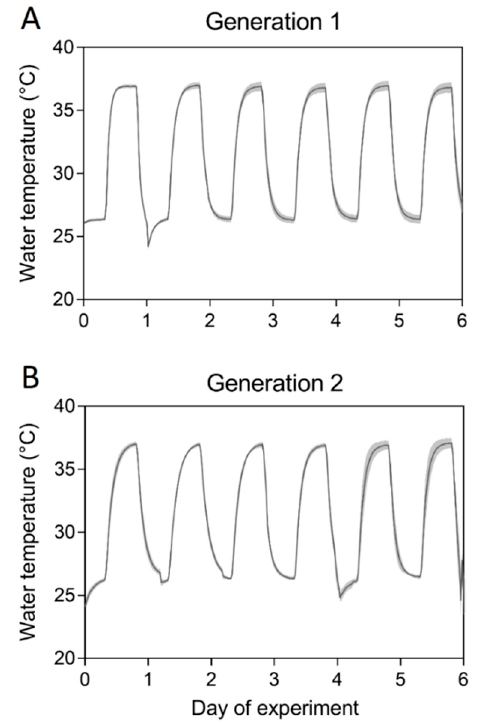
Figure A1 . Diurnal fluctuating temperatures in water containers in the first ( A ) and second ( B ) generation. Black lines indicate the mean temperature recorded by 6 iButtons, with the shaded area representing 95% confidence intervals.